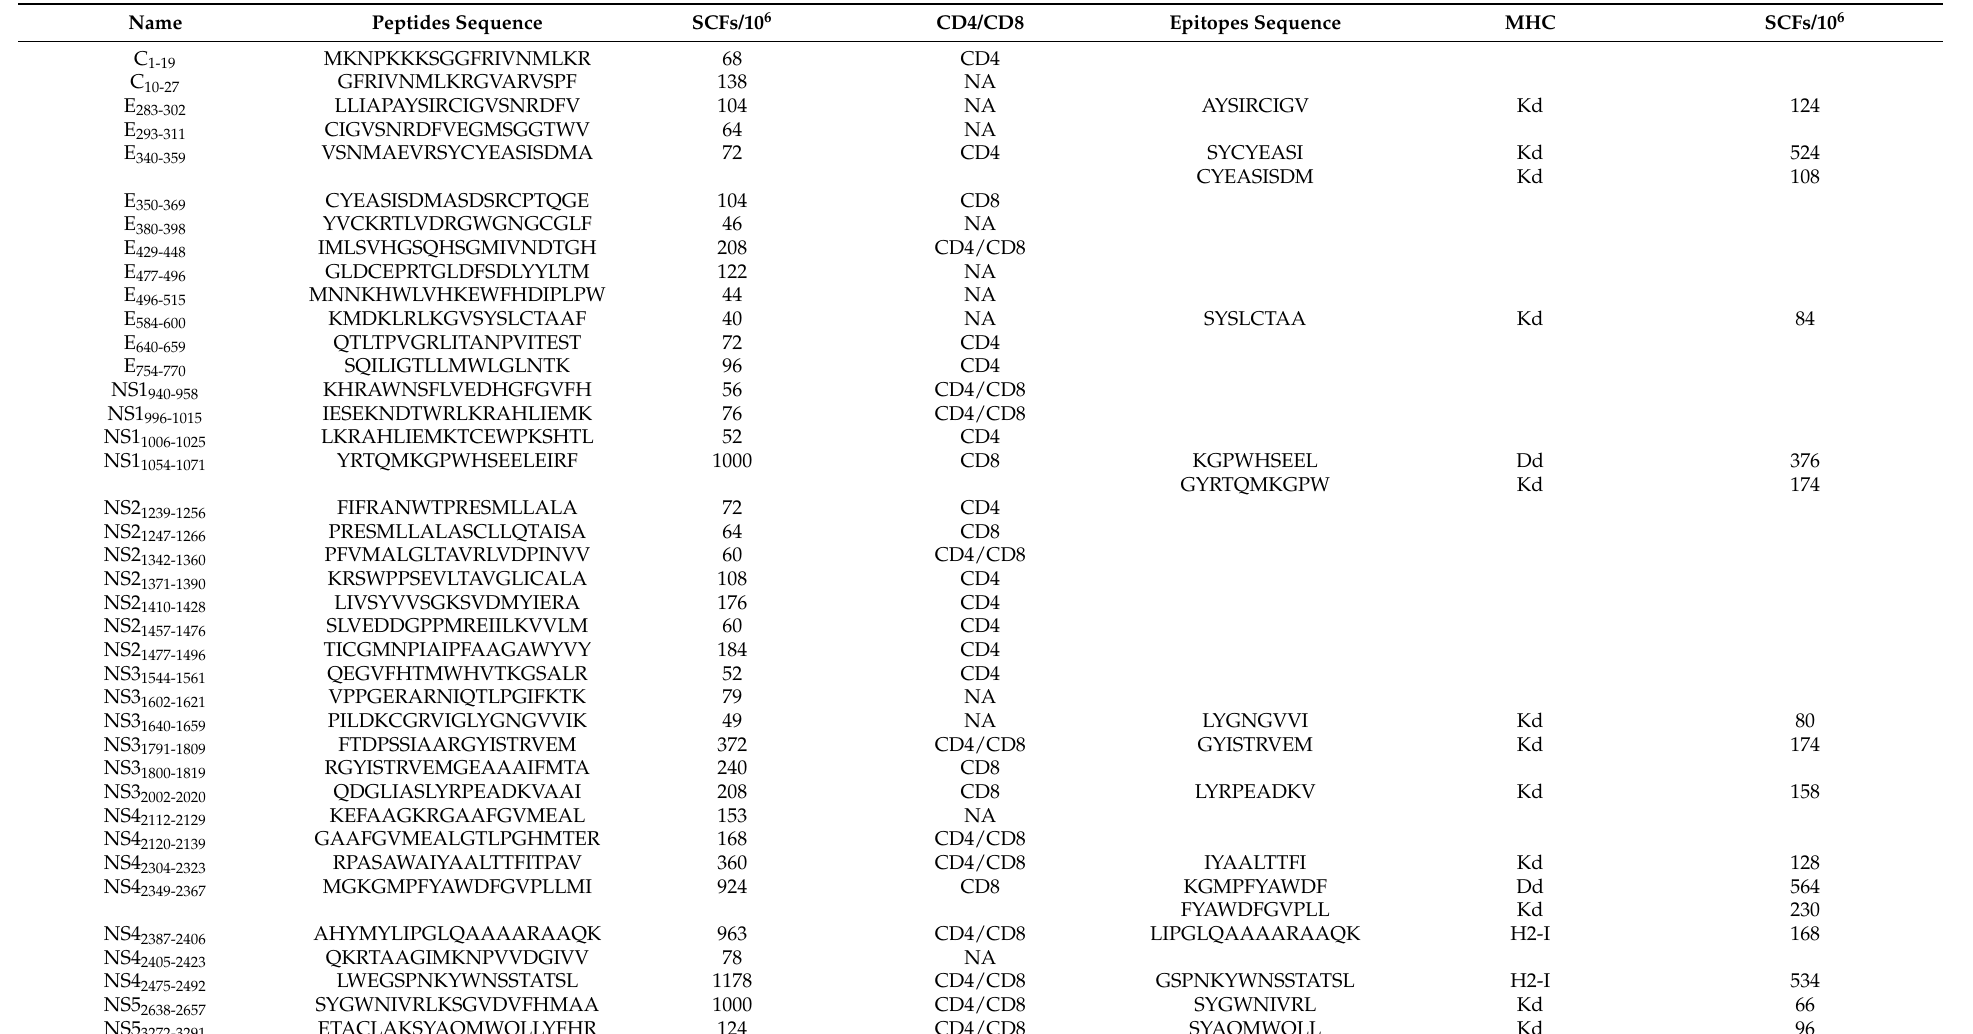
Table 2. H-2 d epitopes of